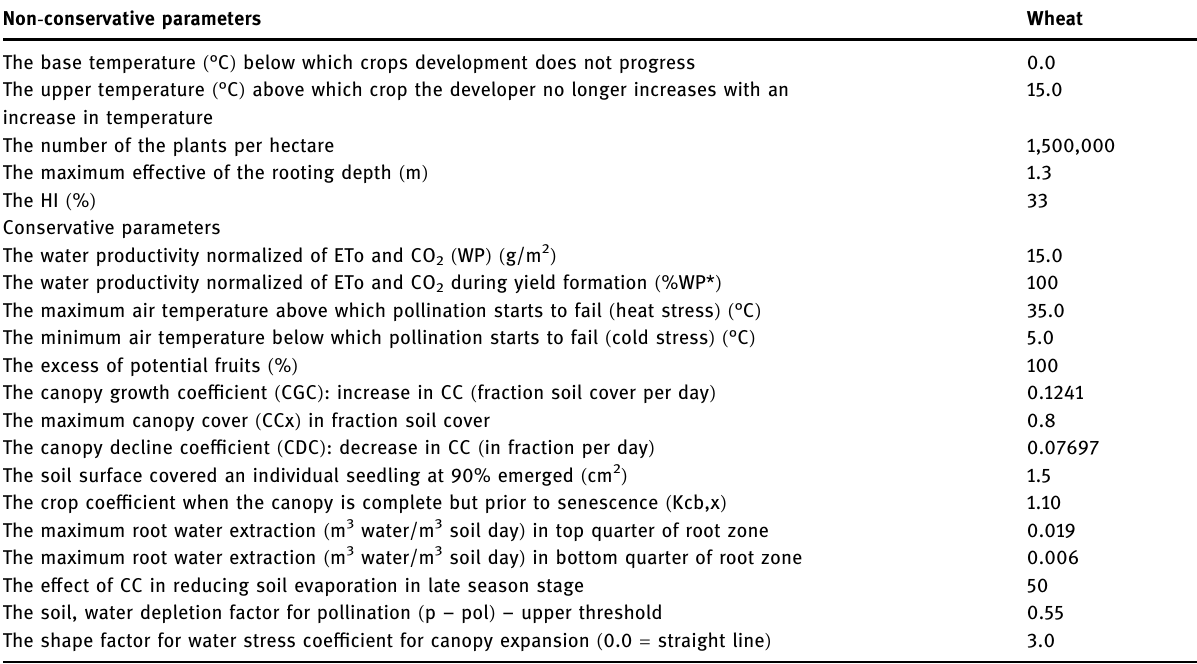
Table 1: The conservative and the non - conservative crop parameters for wheat obtained from di ff erent sources Non - conservative parameters Wheat